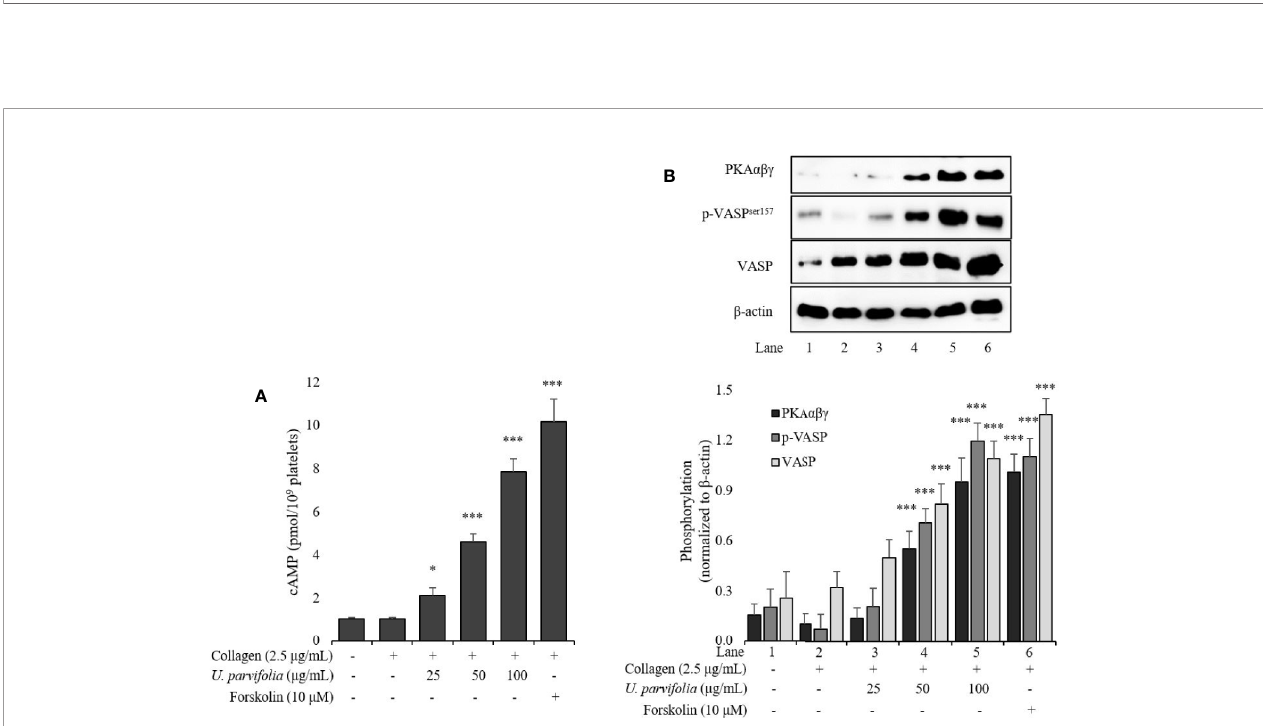
FIGURE 5 | U. parvifolia elevates cAMP production and enhances VASP and PKA abg phosphorylation. (A) cAMP immunoassay performed for collagen-stimulated washed platelets pre-treated with various U. parvifolia extract concentrations, vehicle, or forskolin. (B) Immunoblotting analysis conducted for the phosphorylation of total VASP, p-VASP ser157 , and PKA abg extracted from platelets. Representative immunoblot images and graphs plotted for the data (mean ± SD values) obtained from at least four independent experiments are shown. * p < 0.05 and *** p < 0.001 versus agonist-treated